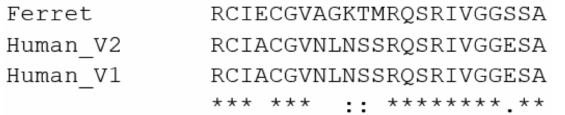
Figure 4. Alignment of human and ferret TMPRSS2 sequences, including the R277-Q290 region. (where * indicates consensus, : indicates conserved change, . is less conserved and a gap in analysis indicates no conservation, as deemed from amino acid